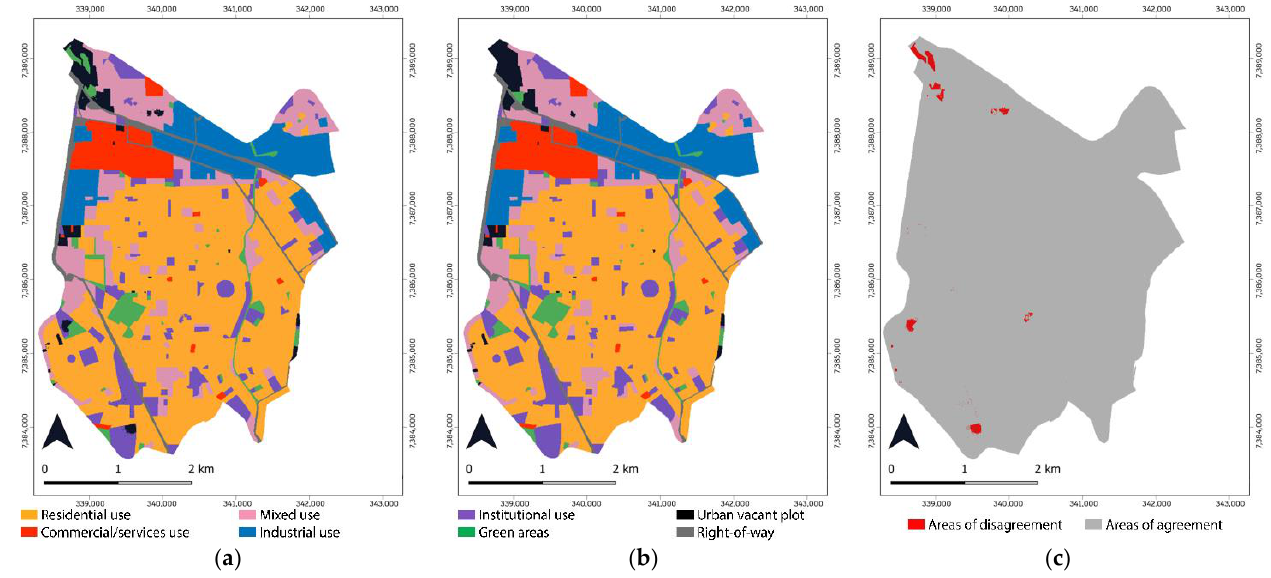
Figure 14. ( a ) Simulated land use map for 2021, ( b ) real land use map in 2021, ( c ) areas of agreement and disagreement.